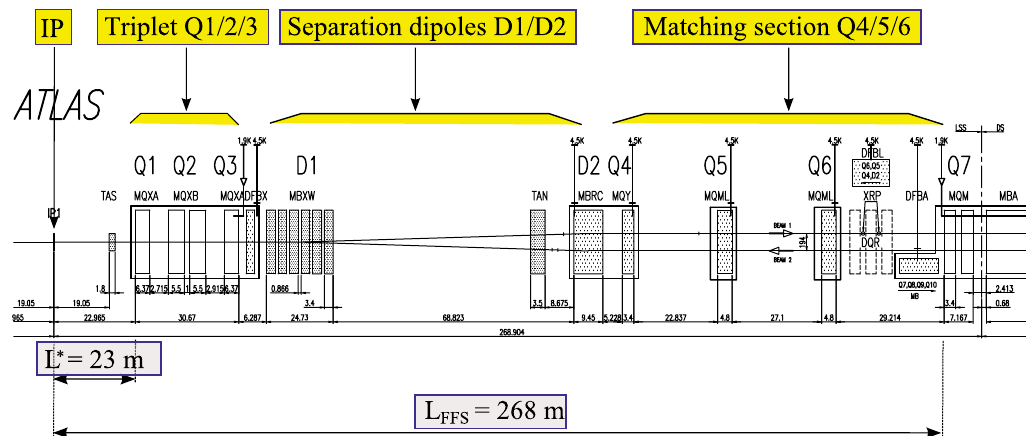
FIG. 2. Low- (cid:1) insertion of the LHC from the interaction point to the entry of the dispersion suppressor [1].